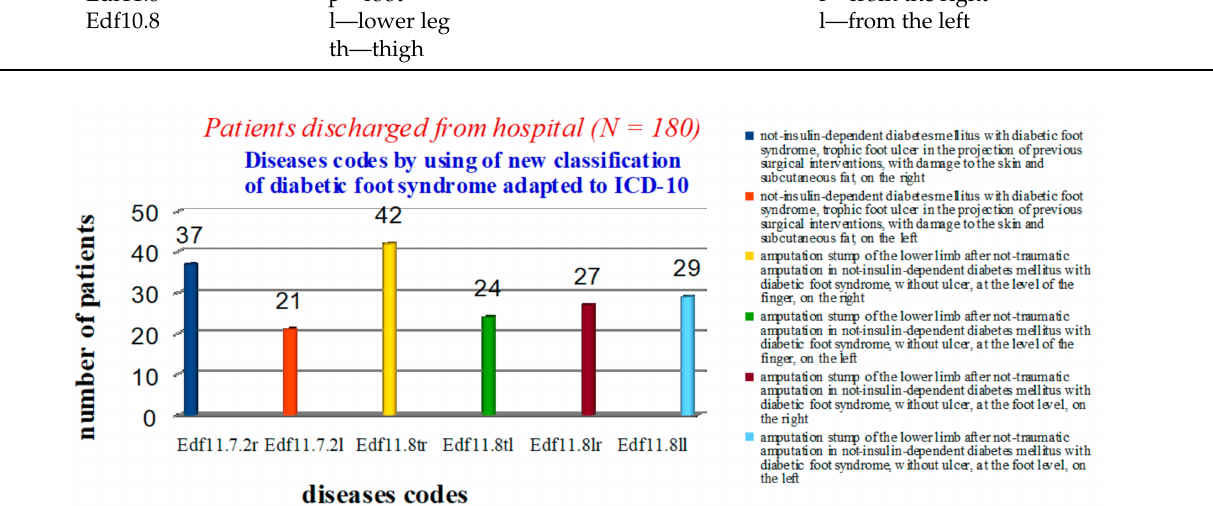
Figure 2. Statistical data on the nosologies of patients discharged from the hospital using a new classification of diabetic foot syndrome, adapted to